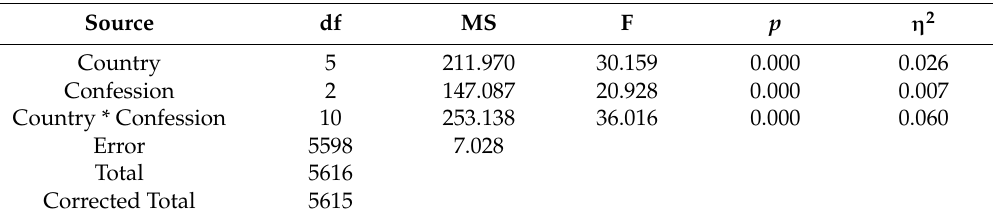
Table A3. Country and confession on the level of religiosity.